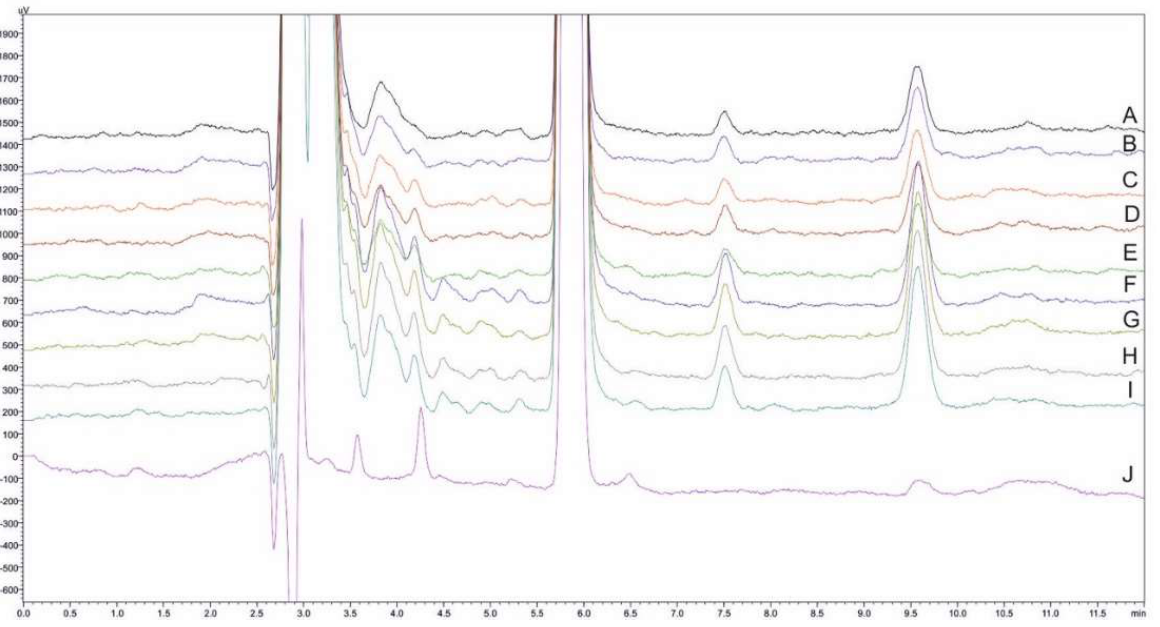
Figure 6. An overlay of chromatograms of the HPLC analysis of the dissolution samples taken at ( A – I ) 5–240 min, and ( J ) PAR standard solution (10% level). The bottom figure is a magnified overlaid chromatogram ( t R , PAR = 5.8 min).